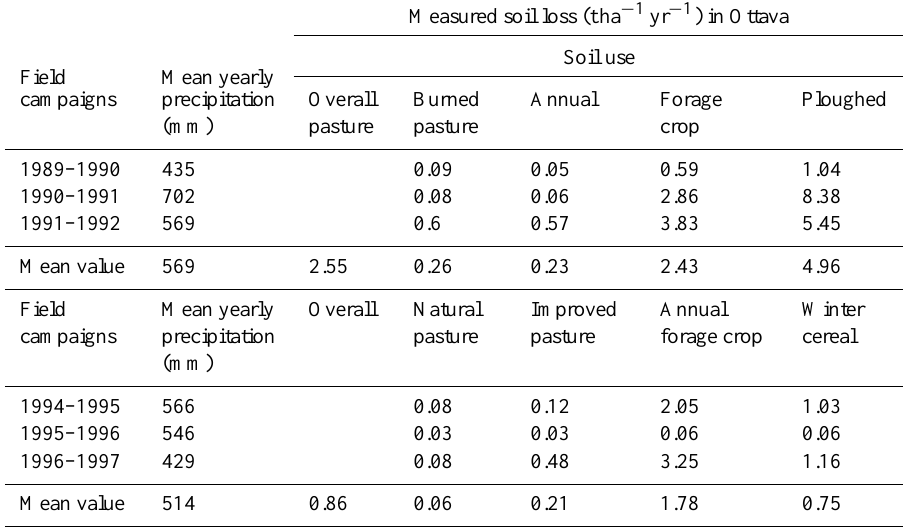
Table 1. Measured soil loss in Ottava at Rio Mannu